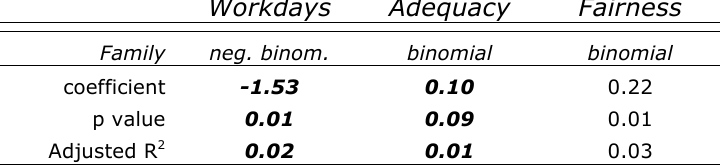
Table A 7. Population-adjusted response correlations. Single linear regressions of each population- adjusted response variable against the population-adjusted caste diversity variable produce a simple measure of the population-adjusted effect of caste diversity on each response variable. The presence of additional caste information is evident in each case. Italics indicate that the direction of the diversity effect agrees with the corresponding multiple regression in the text. Boldface indicates which multiple regression found caste diversity to be a significant